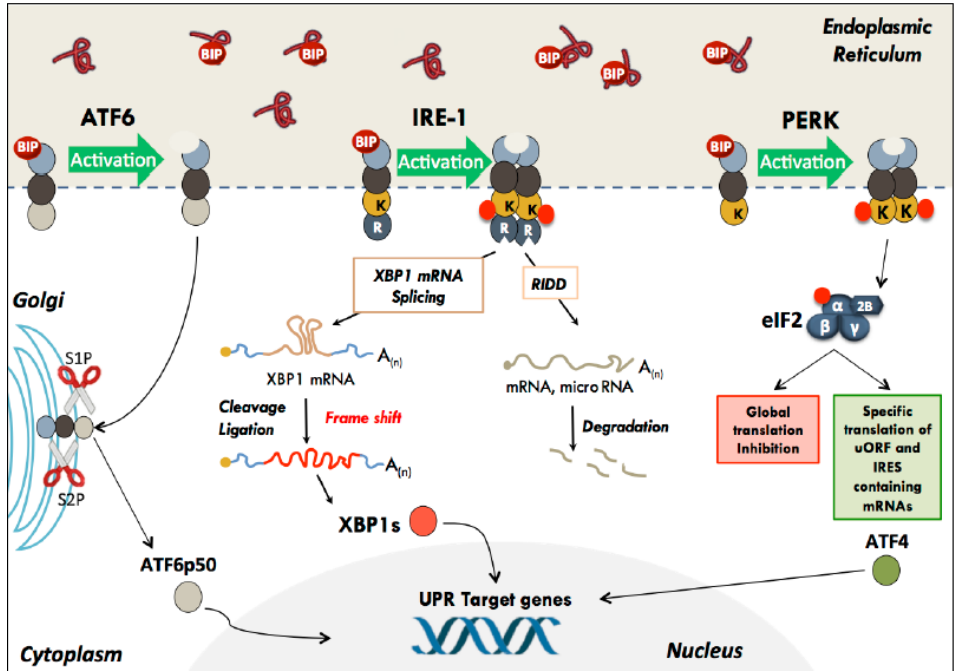
Figure 1. The different UPR effectors and their modes of action. In the basal state, the three UPR effector transmembrane proteins (PERK, ATF6, and IRE ‐ 1) are maintained inactive through their interaction with the protein chaperone BiP. The accumulation of poorly folded polypeptides in the ER lumen results in dissociation of BiP and activation of UPR. –I ‐ PERK dimerises and phosphorylates the eIF2 α subunit, leading to a global translation initiation inhibition. Specific mRNA subsets, containing cis ‐ acting elements in their 5 ′ UTR, such as uORF and IRES, escape translational inhibition triggered by eIF2 phosphorylation. –II ‐ IRE ‐ 1 initiates an unconventional splicing of XBP ‐ 1 mRNA, as well as the degradation of some RNAs (this mechanism has been called RIDD for Regulated Ire1 ‐ Dependent Decay) –III ‐ ATF6 traffics to the Golgi where proteolysis liberates its transcription factor amino ‐ terminal domain, which is nuclearised and activates the expression of target genes.